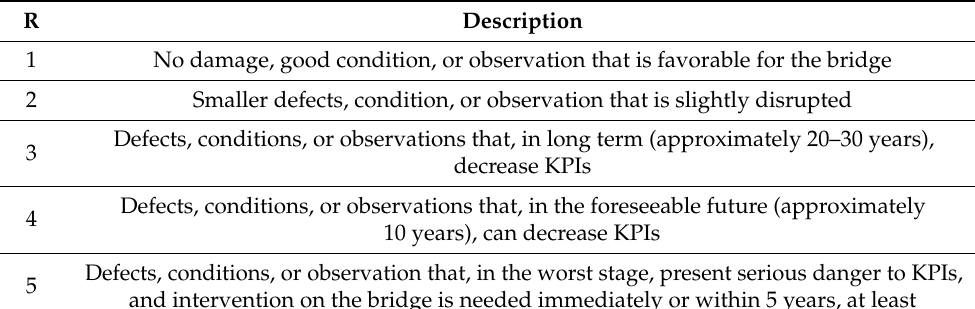
Table 5. Description of the rate of the performance indicators (R).